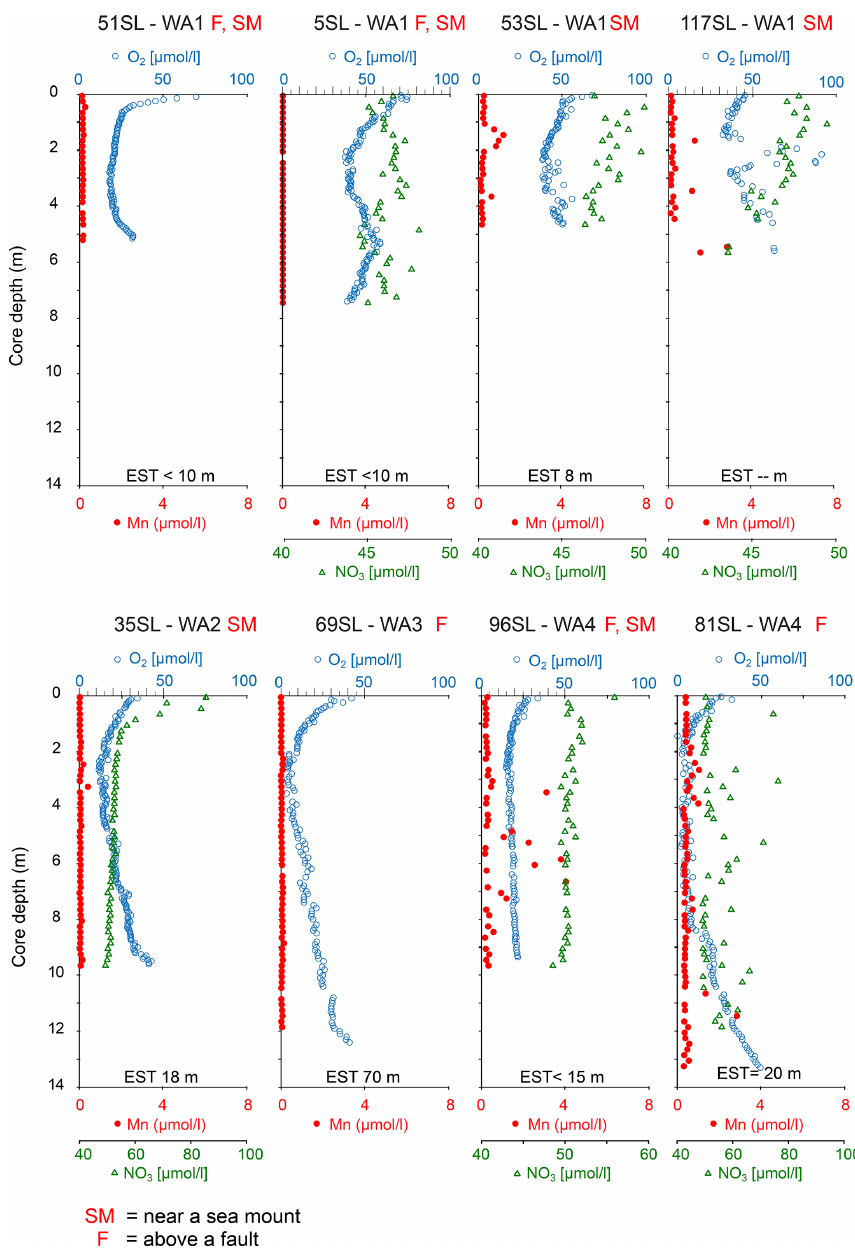
Figure 2. Dissolved oxygen, manganese and nitrate profiles of cores without free porewater Mn 2 + . For all cores, nitrate profiles do not display significant denitrification beyond the uppermost metre (e.g. in 35SL). It is important to note that core 5SL may reflect disequilibrium conditions due to recent slumping and that nitrate increase with depth for 81SL is aberrant, as is the absence of free manganese. EST denotes estimated sediment thickness for each core (from Table 1). For cores 51SL and 69SL nitrate analyses were not possible due to insufficient porewater